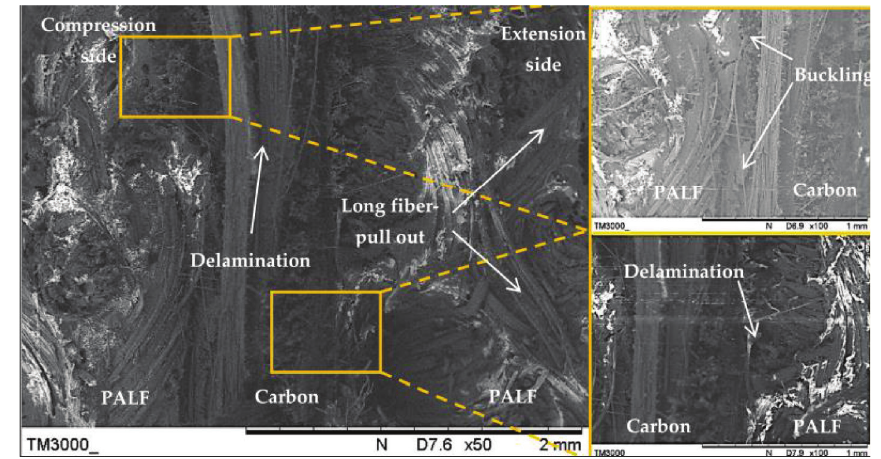
Figure 7: SEM images of the laminate with a carbon ply interior (PCCP) and ply orientation [0 ° , 90 ° ] [181].